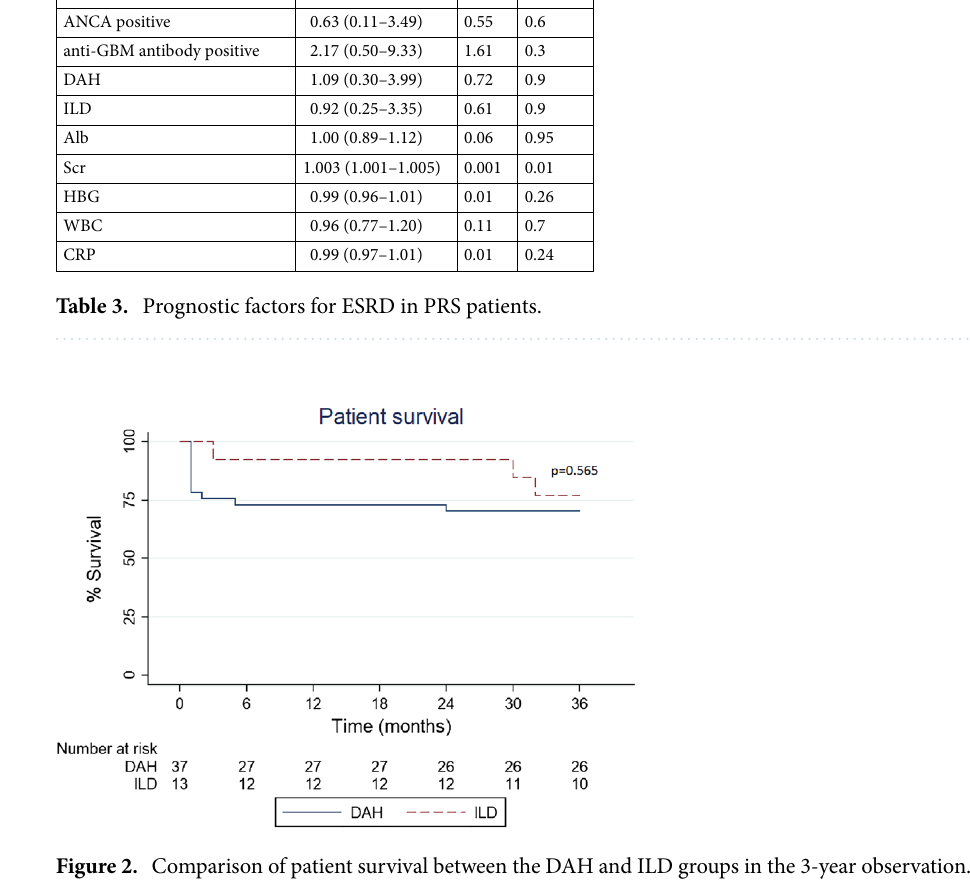
Figure 2. Comparison of patient survival between the DAH and ILD groups in the 3-year